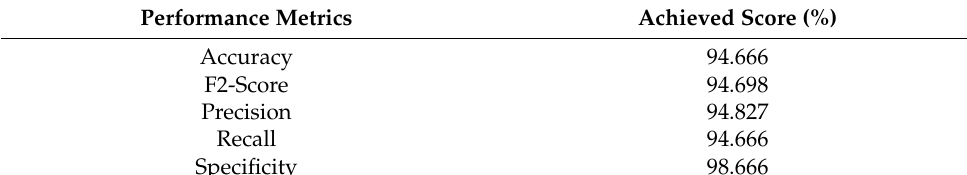
Table 11. Performance metrics of DenseNet169 for five-class classifier.